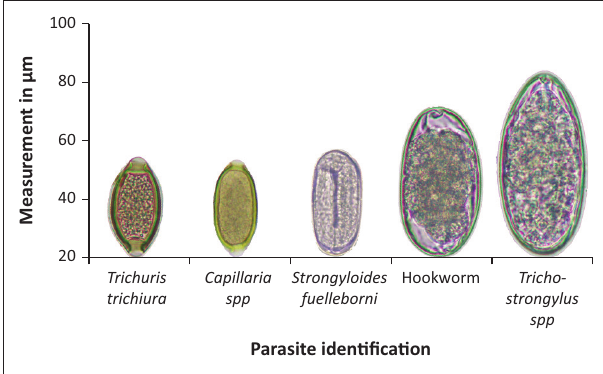
FIGURE 1: Morphologic identification of nematode egg species found (measurements in